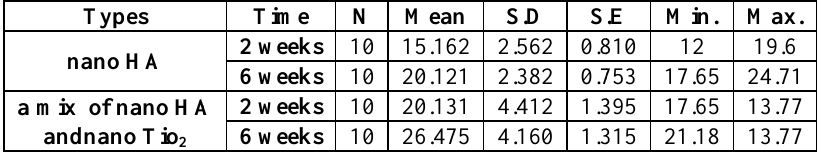
Table 1: Comparison of mean of torqu